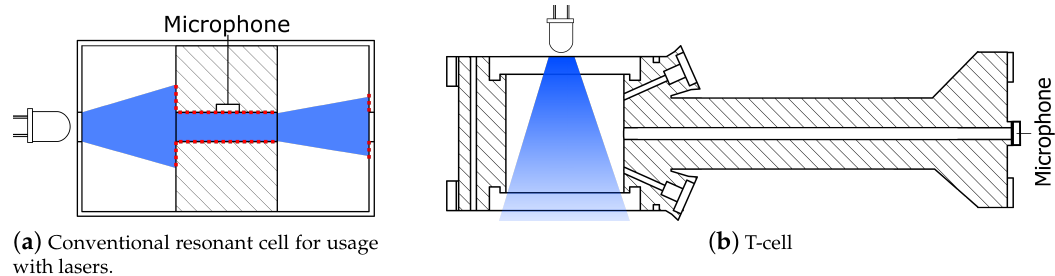
Figure 2. ( a ) Schematic drawing: Diverging LED light within a non-optimized resonant cell similar to that proposed in Ref. [5]. The light hits the inner walls at the red dashed line, causing the background signal. The lower signal to offset ratio results in a worse limit of detection and stability problems. ( b ) Concept for use of LED light. The T-cell consists of an absorption chamber that enables the non-contact feedthrough of the beam. Perpendicular to it there is the resonance cylinder, where the standing wave pattern is